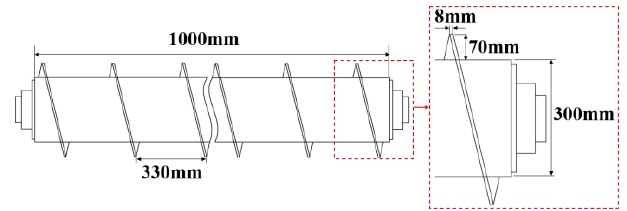
Figure 5. 2D model of screw-type dryer.